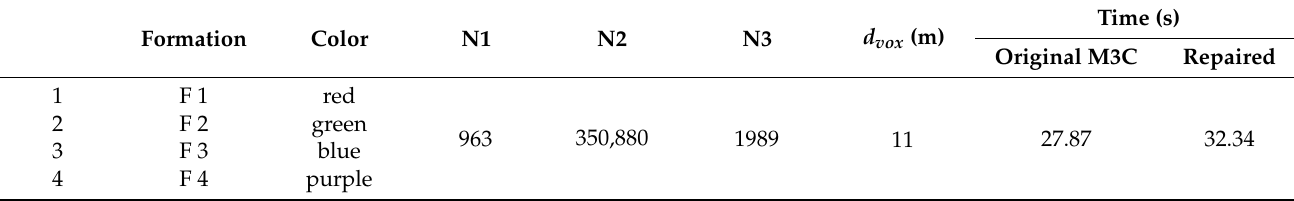
Table 3. The four-formation geological body statistics table. N1 is the number of the constraint points, N2 is the number of the voxel points of the models, N3 is the number of the voxel points that change their labels, and d vox is the voxel size.